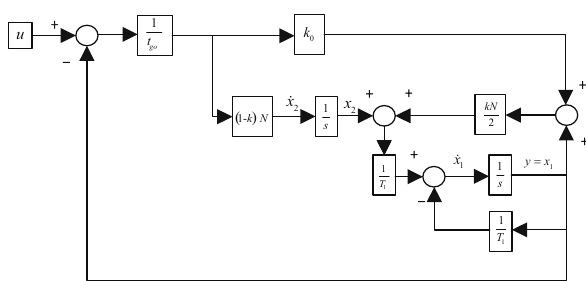
Figure 4: State space block diagram of fi rst - order linearized AACG guidance